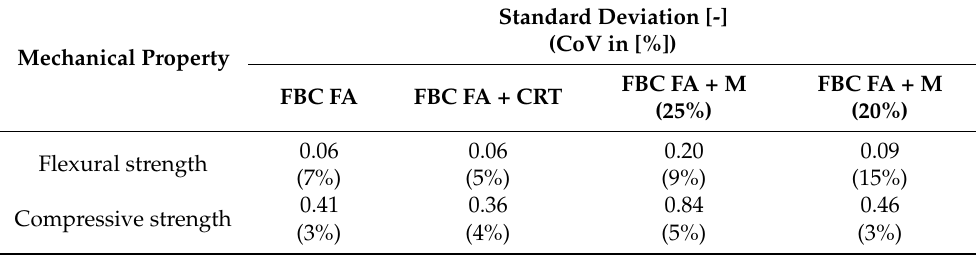
Figure 2. Flexural and compressive strength of geopolymer samples made of different mixtures. Table 3. Standard deviation and coefficient of variation of series of samples tested after 7 days.